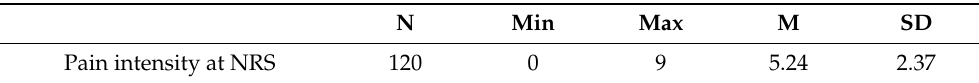
Table 2. Pain intensity at NRS.